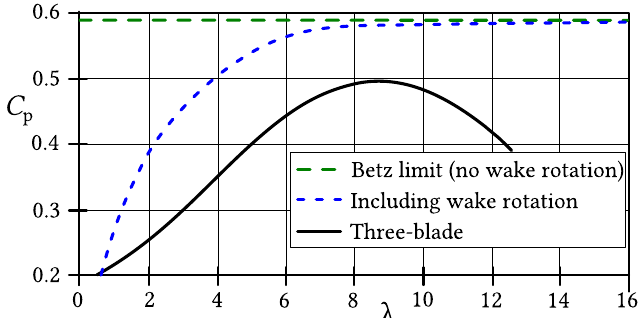
Figure 7. Operation limits of wind turbines from simplified models and typical horizontal axis three-blade